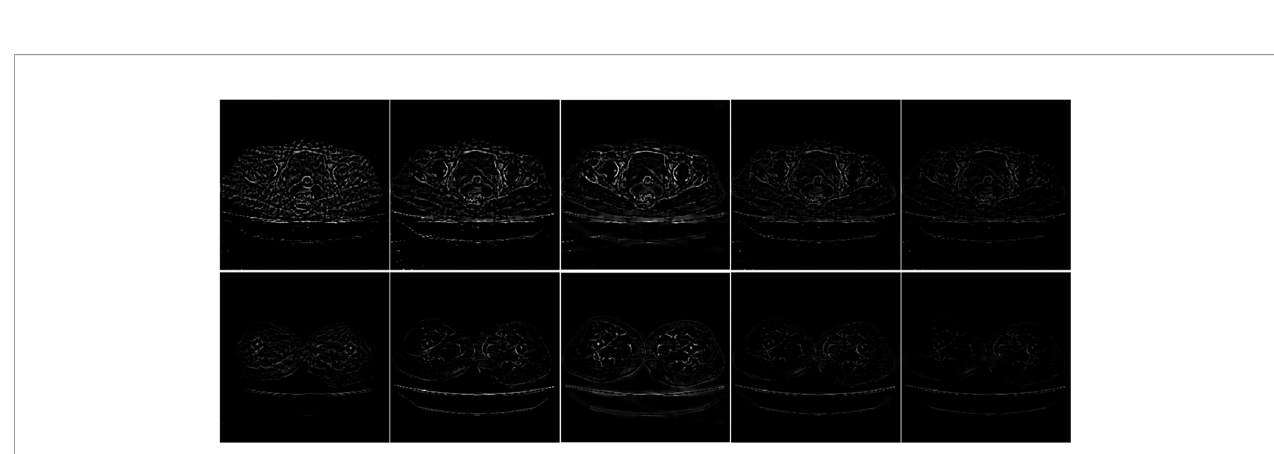
FIGURE 8 | The absolute difference between the reconstructed image and the reference image.